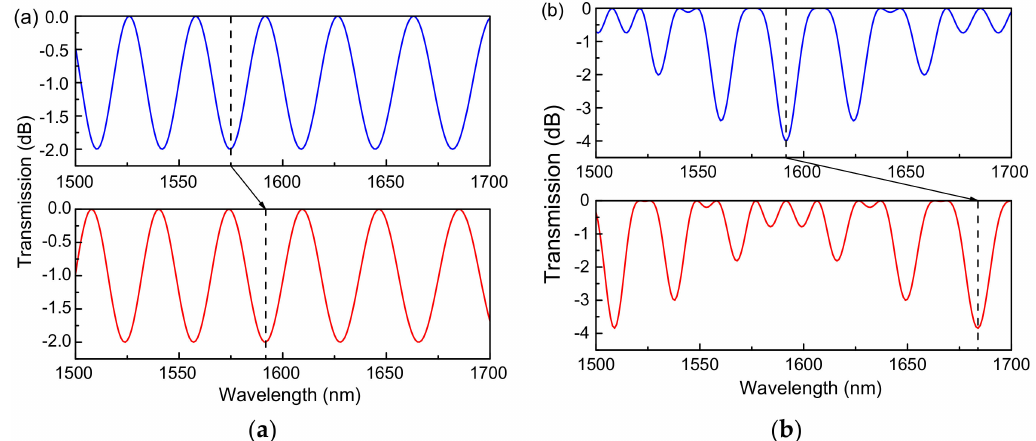
Figure 2. The simulated transmission spectrum shifts of ( a ) a single Sagnac-interferometer microfiber sensor and ( b ) a cascaded Sagnac-interferometer microfiber